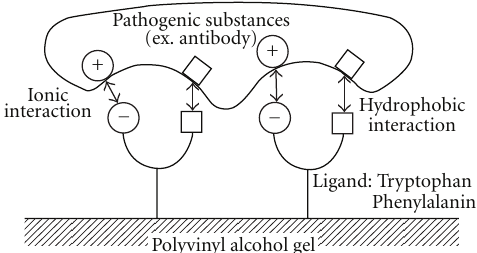
Figure 11: The schema of Immusorba PH-350 and TR-350. The a ffi nity between ligand of these columns and antibody was mainly hydrophobic interaction and partially caused by the ionic interaction based on carboxylic group.